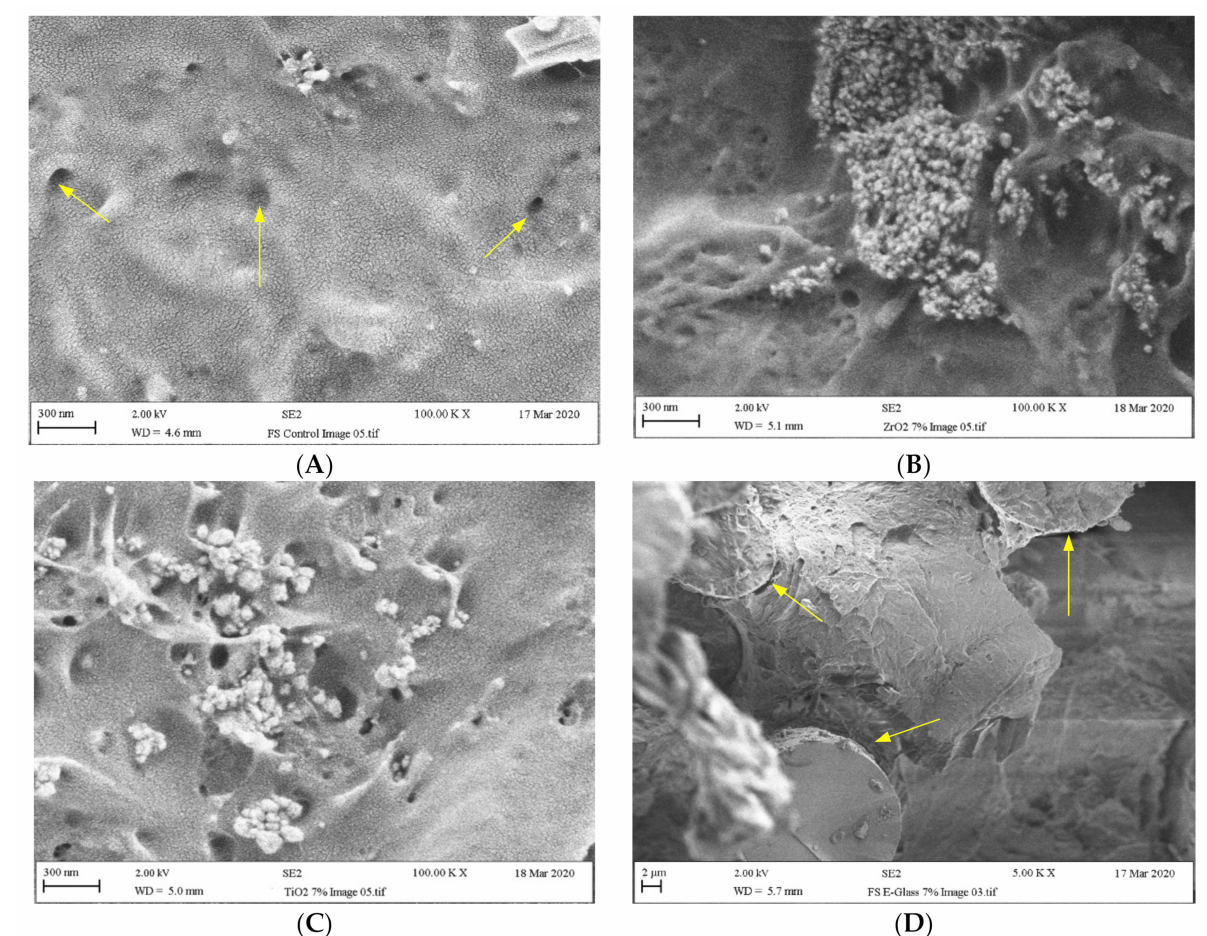
Figure 4. Fractured surfaces of ( A ) pure heat-cured PMMA (arrow showing pores) and reinforced composites (Group C) with ( B ) ZrO 2 nanoparticle (Z7), ( C ) TiO 2 nanoparticle (T7), and ( D ) E-glass fibre (E7; arrow showing gap between fibre and